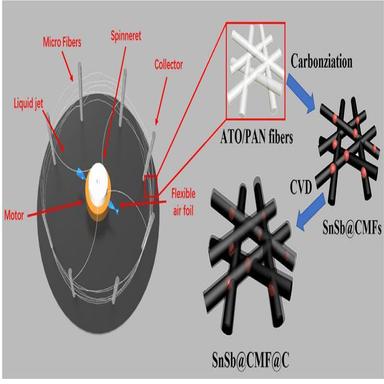
Schematic of the centrifugal spinning process and the preparation of SnSb@CMF@C.